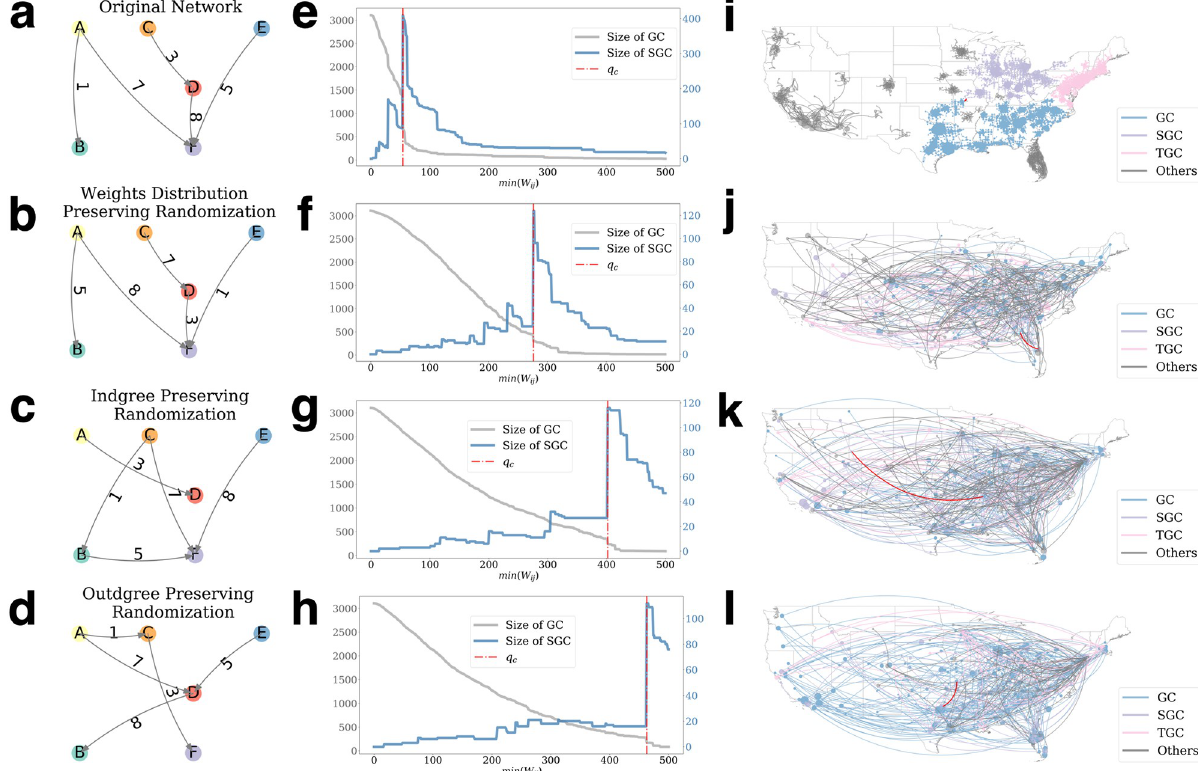
Fig 6. Results from randomization and their comparison to the original mobility data. a A sub-network of the original mobility network with their weights illustrated. The sub-network’s percolation process is shown in e and its largest components at q randomization to the original networks: randomly assigning weights with distribution unchanged ( b ), randomly shuffling the weights while each node’s in-degree remain unchanged ( c ), and randomly shuffle the weights while each node’s out-degree remain unchanged ( d ). Examples of the percolation processes of the three types are shown in f, g, and h respectively, and their largest components at q c are shown in j, k, and l .